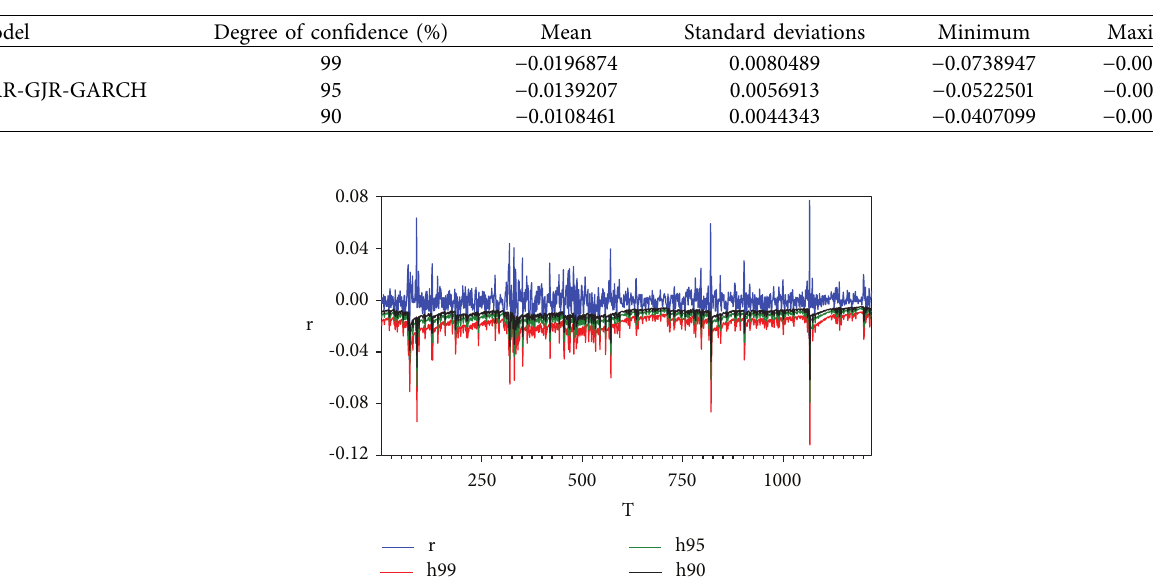
Figure 3: Comparison of VAR-GARCH model risk value and return rate at different confidence levels. Table 9: Risk value calculation of the two models at different confidence levels.